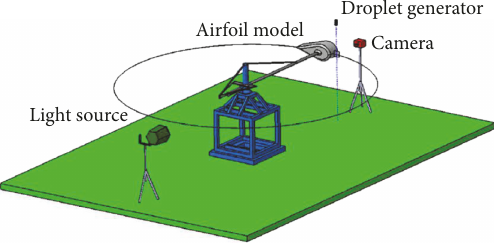
Figure 2: Sketch of the facility.